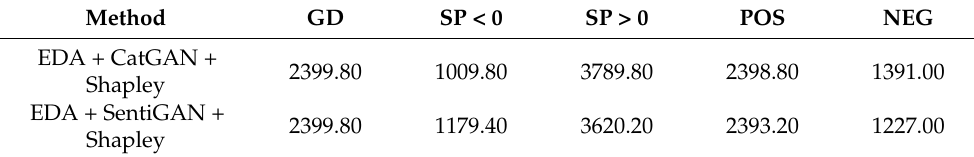
Table 4. Statistics of the results filtered by the Shapley algorithm of the two GAN-based